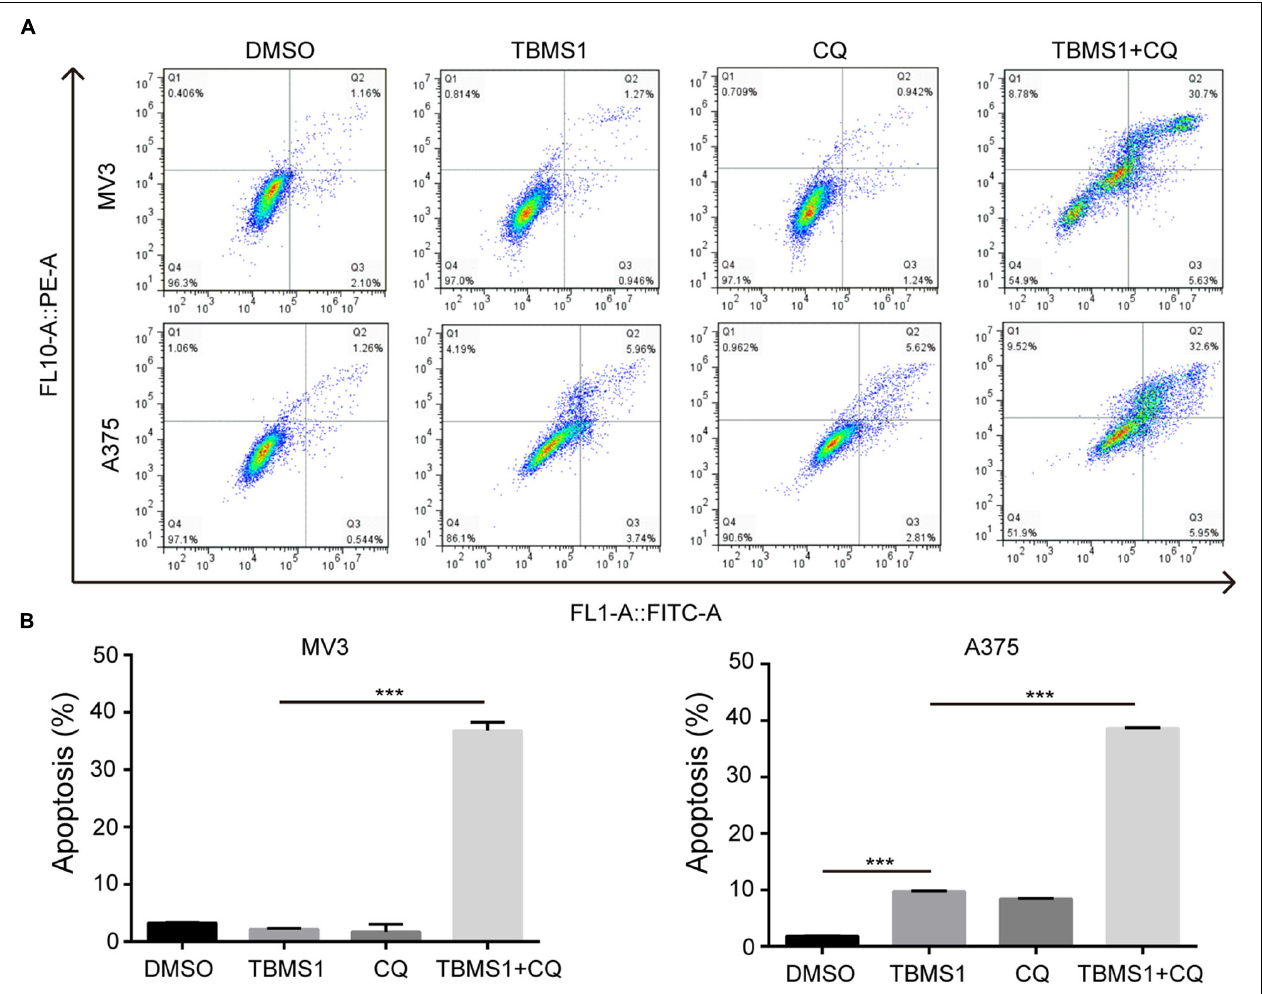
FIGURE 3 | Block of autophagy triggers apoptosis in TBMS1-treated melanoma cells. (A,B) Apoptosis was examined in MV3 and A375 cells after treated with TBMS1 and 20 µ M CQ for 48 h. DMSO was used as control. Apoptotic rate of MV3 and A375 cells was quantified. A two-tailed unpaired Student’s t -test was carried out. * p < 0.05, ** p < 0.01, *** p < 0.001, **** p <